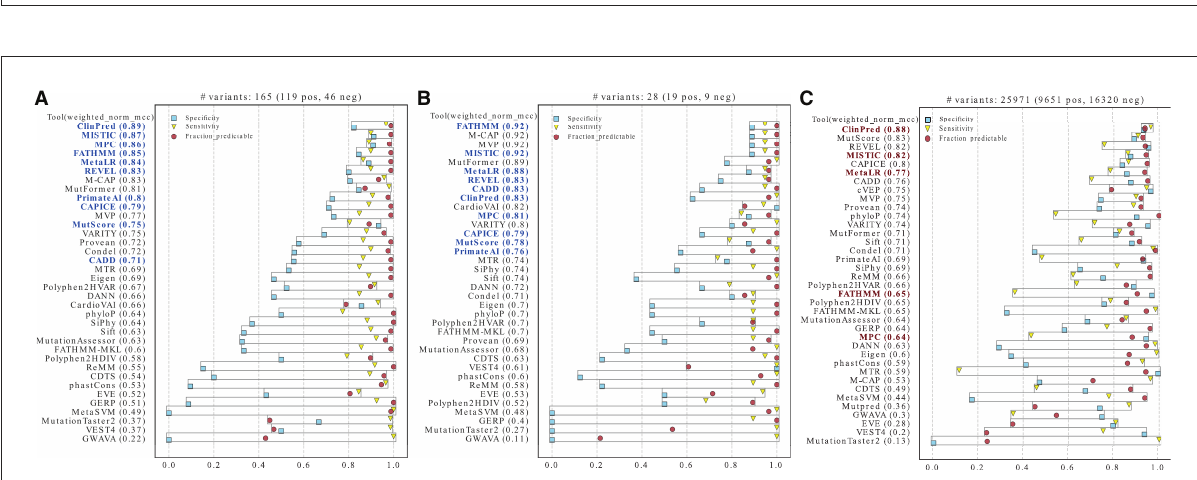
= 0.5 minimize the false positives (variants predicted as pathogenic that are benign). Optimized thresholds at Beta 1 give the same importance = 1.5 minimize the false negatives (variants predicted as benign that are =